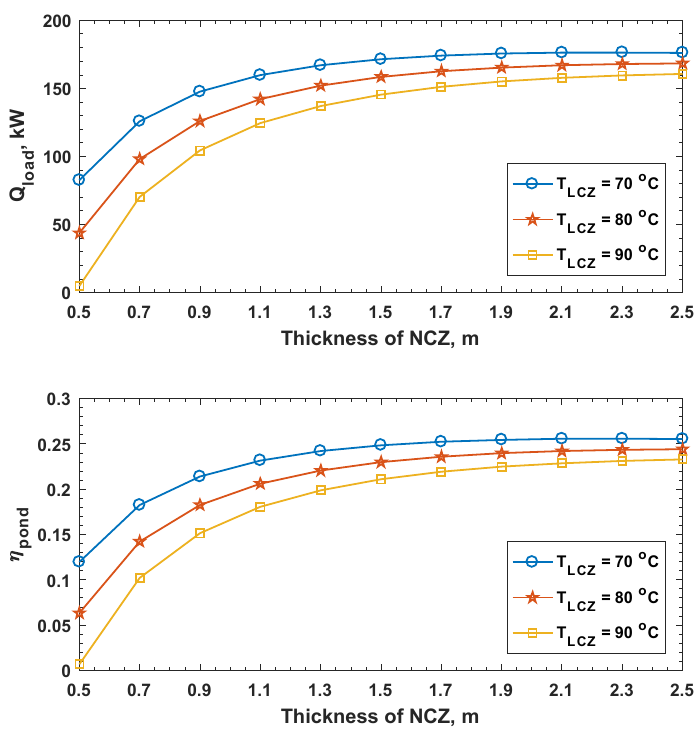
Figure 3. Effect of NCZ thickness and LCZ temperature on the performance of the pond.